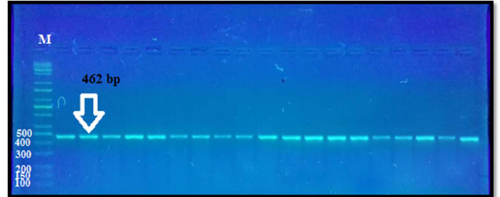
Fig. 1. The PCR product of exon I GDF-9 gene. M = DNA